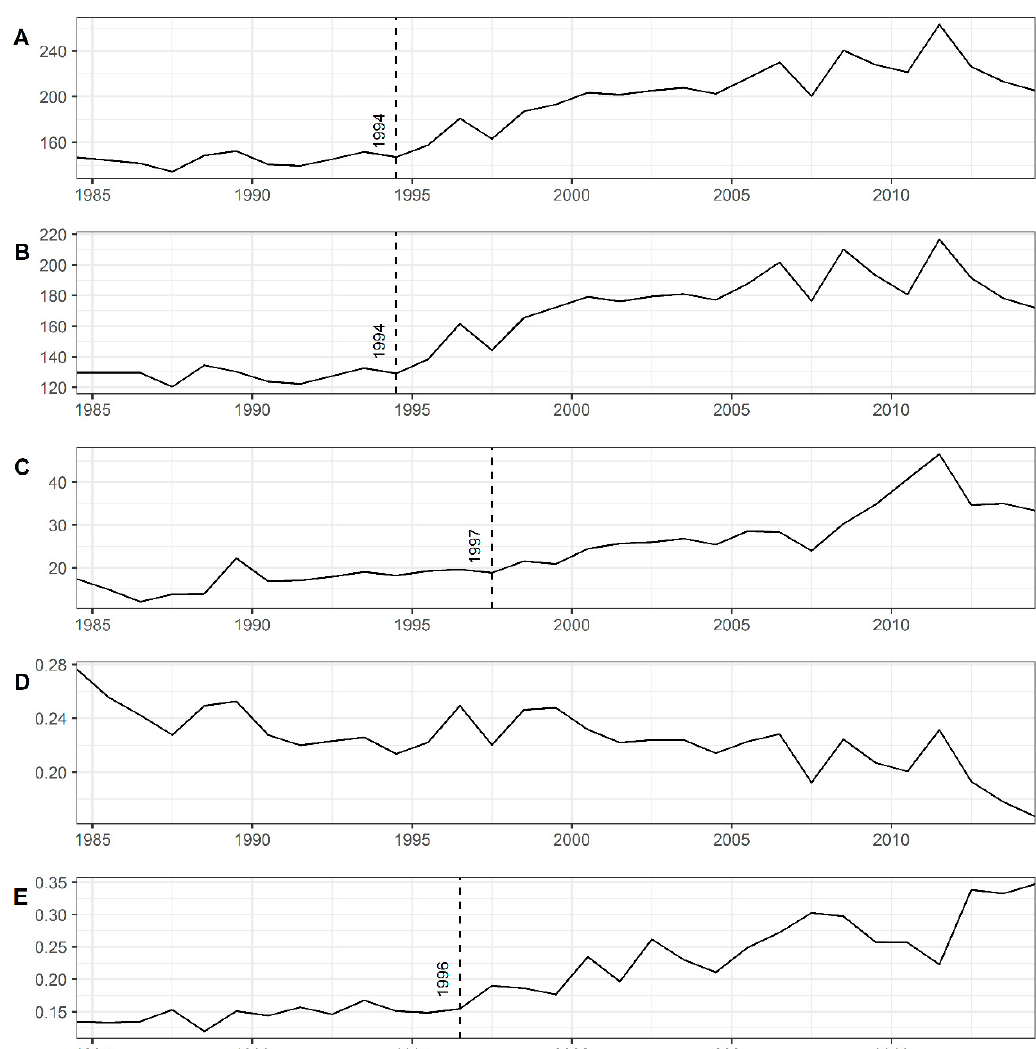
Figure 5. Change points for annual water use by urban counties from 1984 to 2014: ( A ) total, ( B ) surface water, ( C ) groundwater measured in thousands of acre-feet (000s AF); ( D ) per capita water use (no change point detected) measured in acre-feet (AF); and ( E ) proportion of total water used.